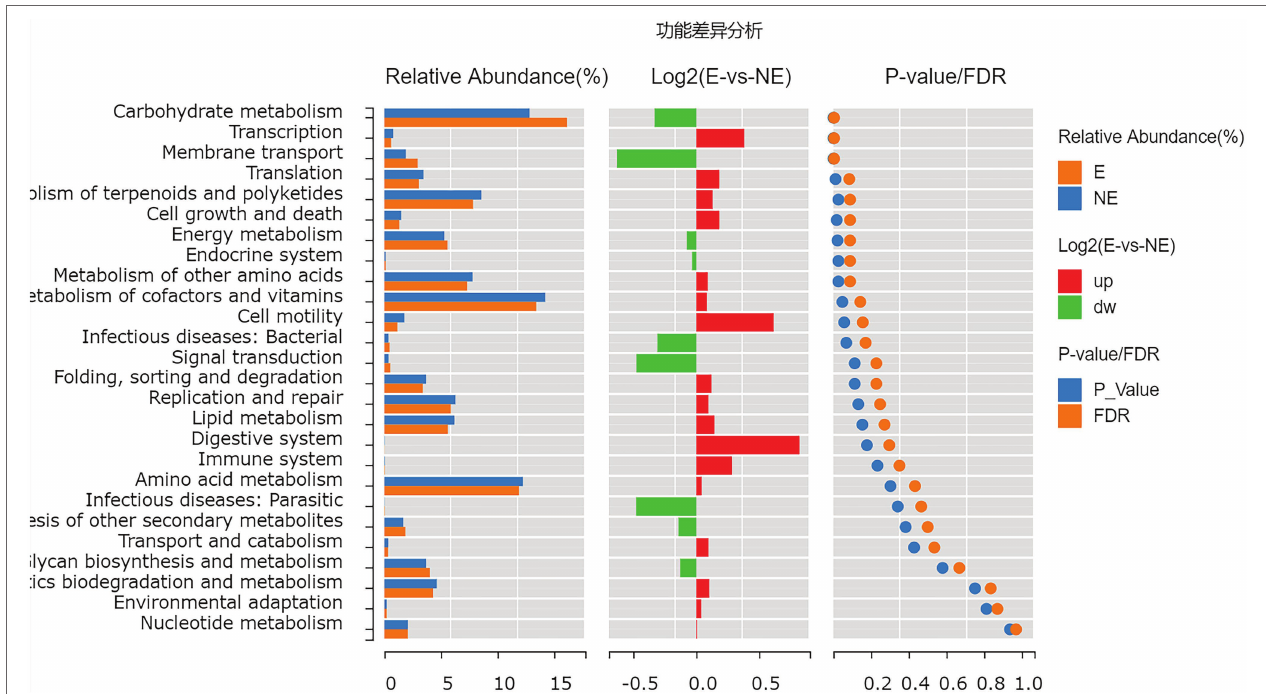
FIGURE 8 | Wilcox Test result map of pathway difference (KEGG level 2). The relative abundance bar chart of each group is shown on the left; the log2 value of the relative abundance mean ratio of the same pathway in the two groups is shown in the middle; and the value of p and FDR values obtained by wilcox test are shown on the right. If the value of p and FDR values are less than 0.05, the pathway is significantly different between the two